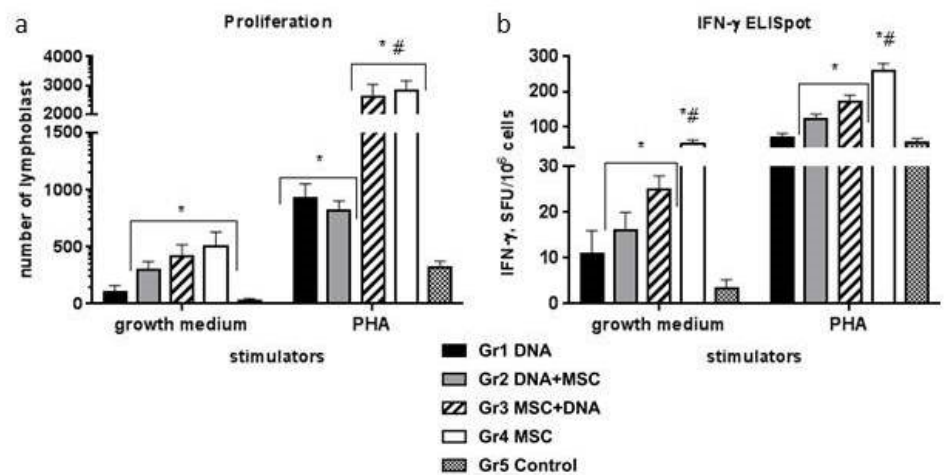
Figure 3. Spontaneous and phytohemagglutinin (PHA)-induced cellular response of lymphocytes from immunized mice in vitro. Each group (5 mice) received the DNA plasmid and/or naïve MSCs during two injections with a three-week interval. To assess the cellular response of the splenocytes in vitro, we used mitogen PHA; the medium alone was used as negative control. ( a ) Results of T-cell proliferation are expressed as the number of lymphoblasts in the cell proliferation reaction; ( b ) the IFN- γ production by splenocytes in response to PHA was assayed as the number of IFN- γ -synthesizing cells by ELISpot as the number of spot forming cells (SFCs) per 10 6 cells; * p < 0.05 compared to the control (Group 5); # p < 0.05 compared to all groups.